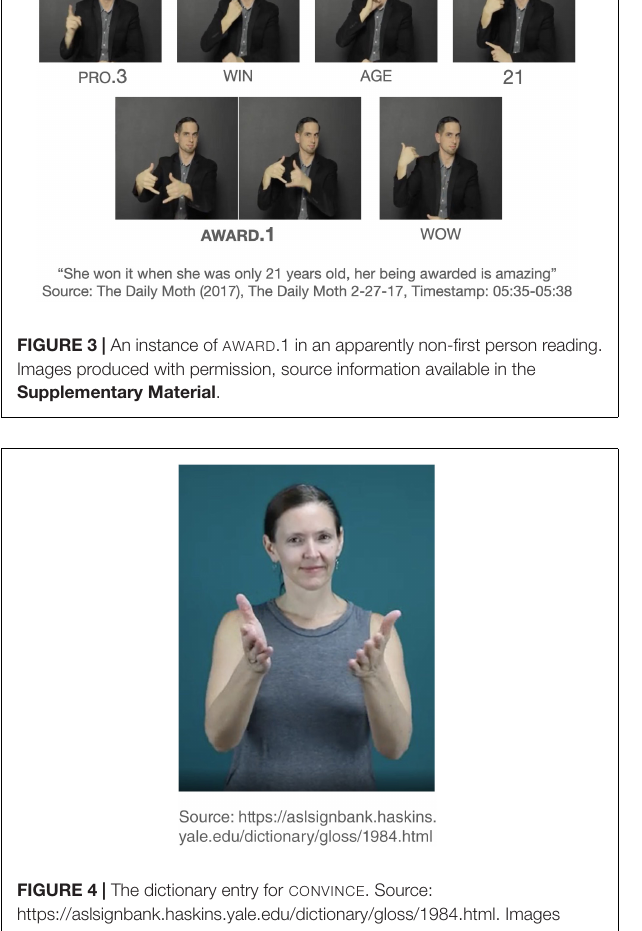
and Meier, 2018). The chest is the most common location for the end point of first-person object forms of directional verbs, so the neck is marked for being the location for the end point of CONVINCE -1. No other directional verb has been documented to occur on the sides of the neck, although a few other signs do occur in the proximity of that location, such “bankrupt”, 7 “vampire,” 8 and “accent” 9